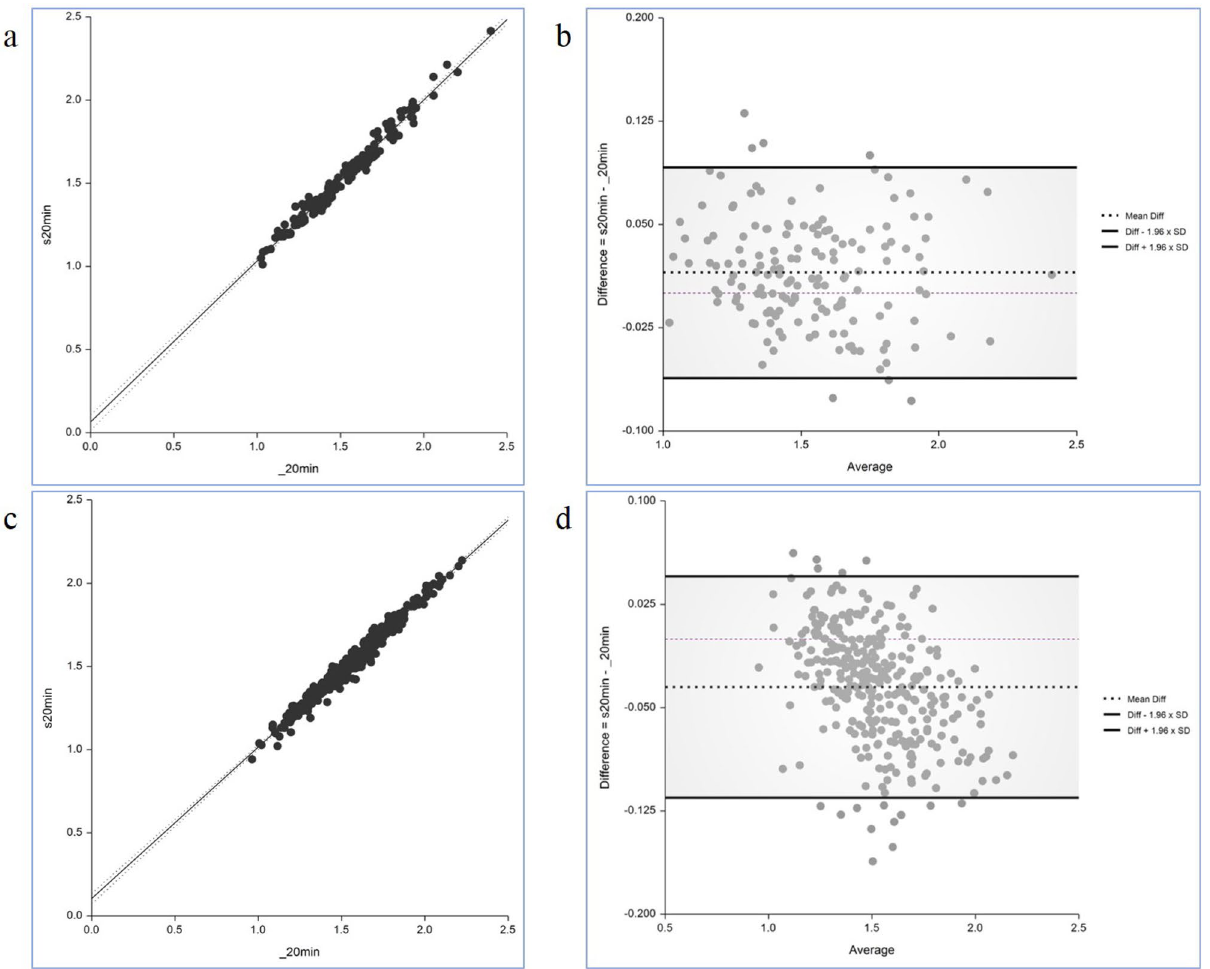
Figure 5. Correlation analysis of the whole representative areas shows a trend of a strong positive relationship of SUVR in temporal ( a ) and external validations ( c ). The Bland–Altman analysis shows a minimal mean difference between the two images in temporal ( b ) and external validations ( d ).